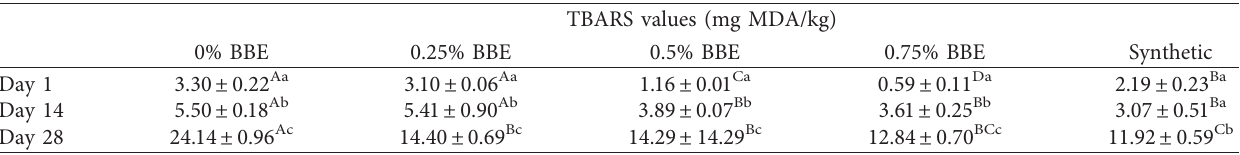
Table 3: The thiobarbituric acid reactive substance (TBARS) inhibitory activity (mg MDA/kg) of fish sausage samples fortified with 0%, 0.25%, and 0.5% BBE and synthetic additives BHT after storage for 1, 14, and 28 days at 4 °